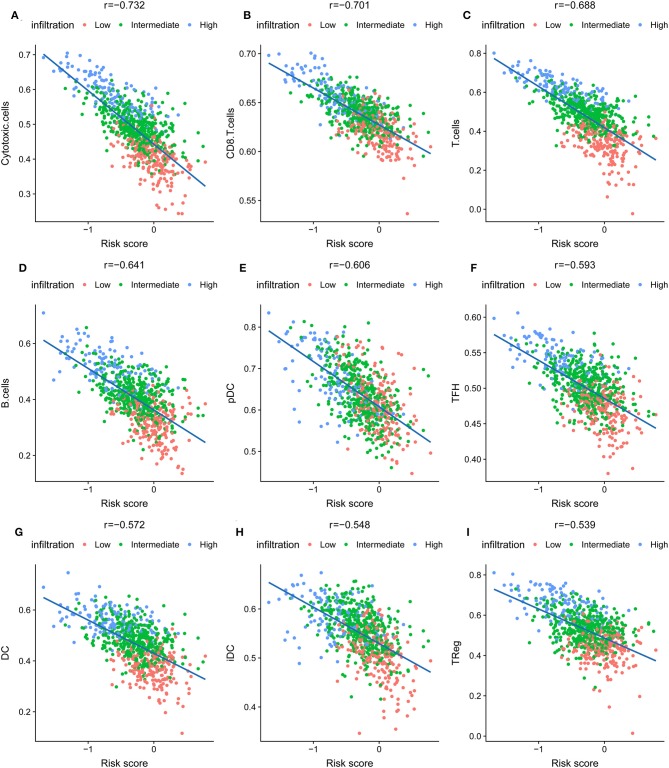
The nine most significant correlations of risk score with immune cell infiltration ssGSEA score. (A) Cytotoxic cells, (B) CD8+ T cells, (C) T cells, (D) B cells, (E) pDC cells, (F) TFH cells, (G) DC cells, (H) iDC cells, (I) Treg cells.